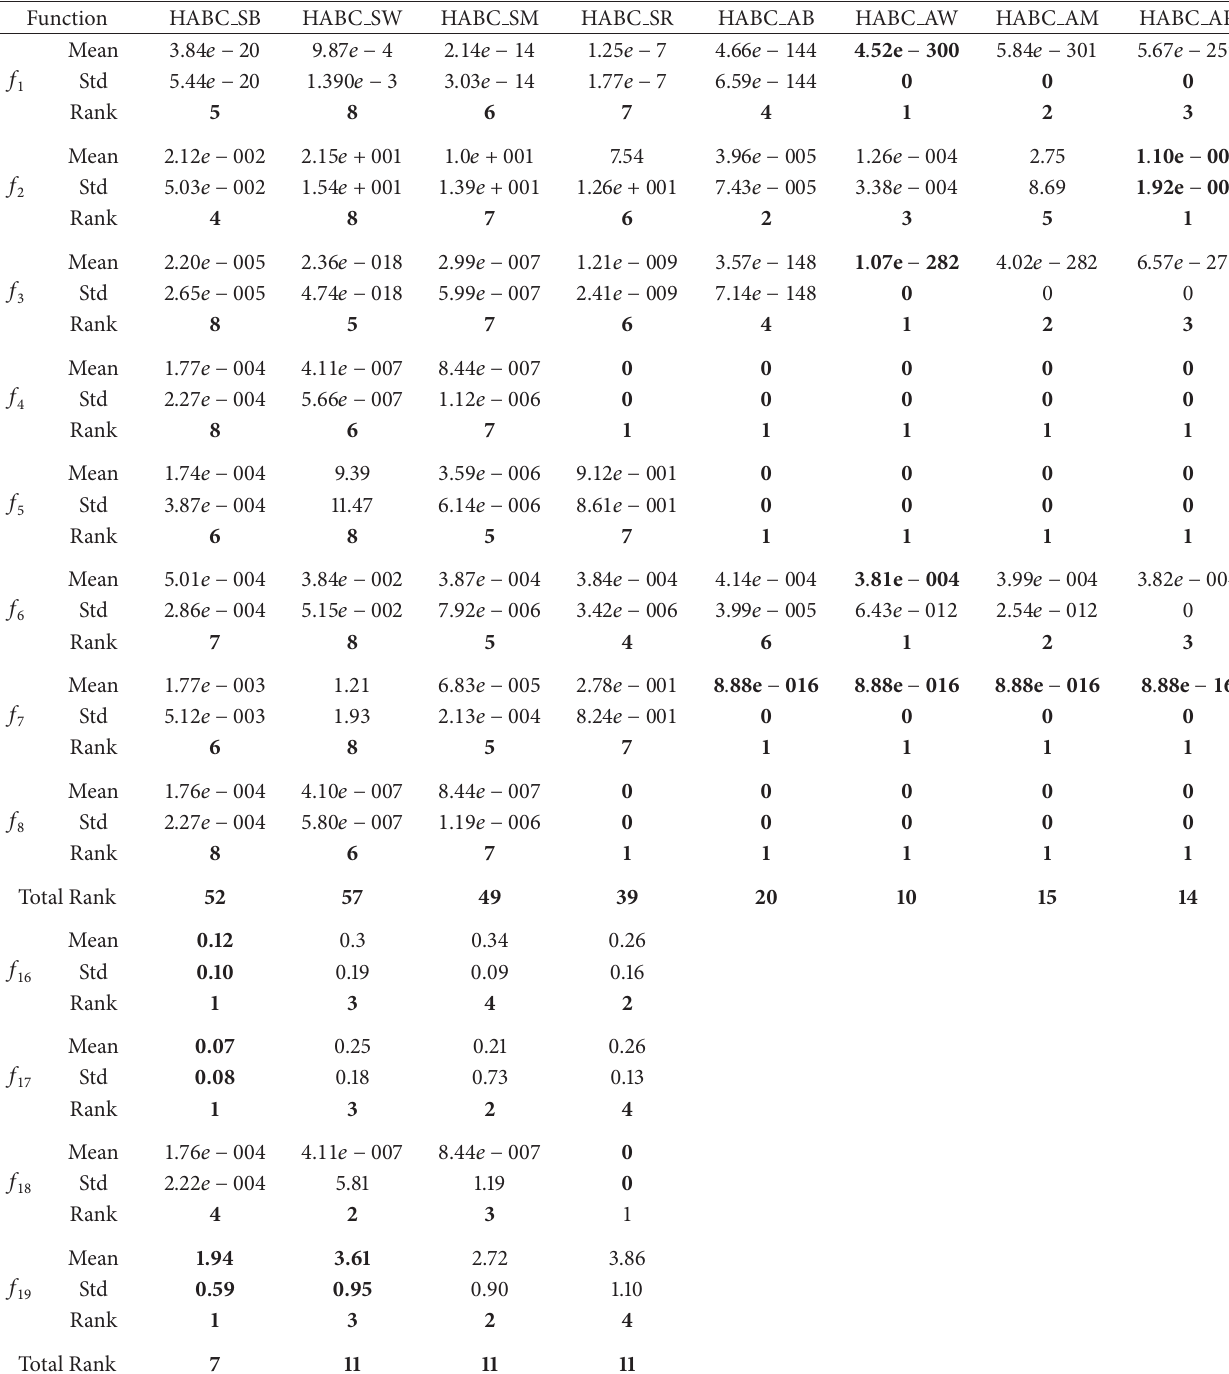
Table 3: Results of all algorithms on benchmark continuous functions 𝑓 1 – 𝑓 8 and discrete functions 𝑓 16 – 𝑓 19 . In bold are the best